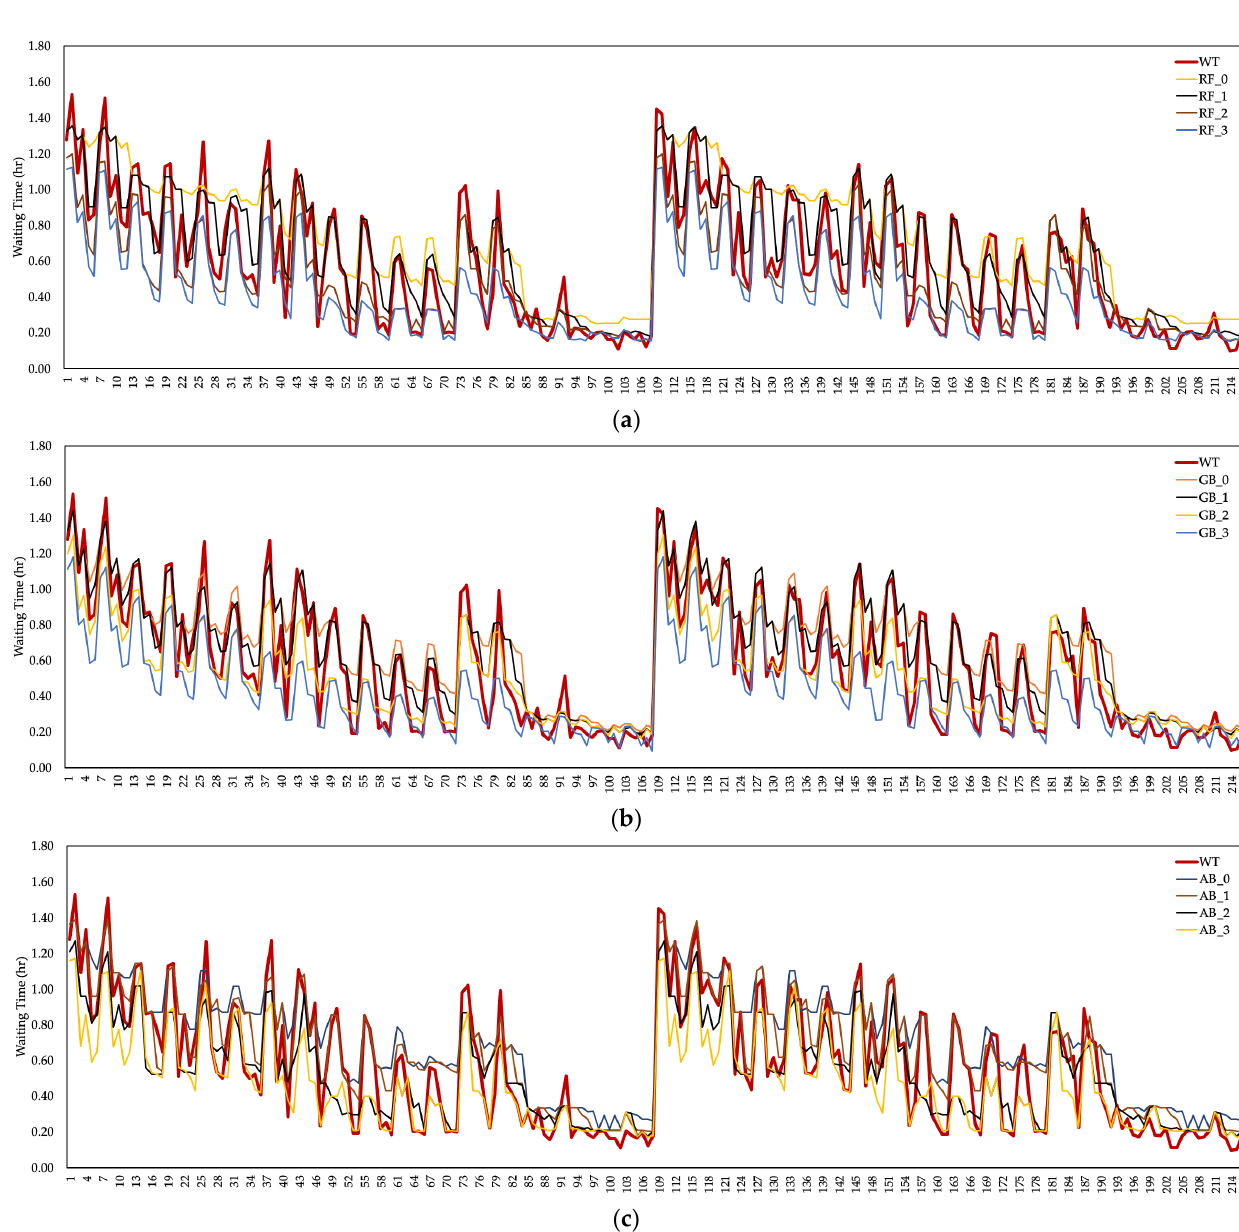
for , for 𝛿𝛿 0 . 0 𝑅𝑅𝑅𝑅 −0 𝛿𝛿 0 . 1 𝑅𝑅𝑅𝑅 −1 𝛿𝛿 0 . 2